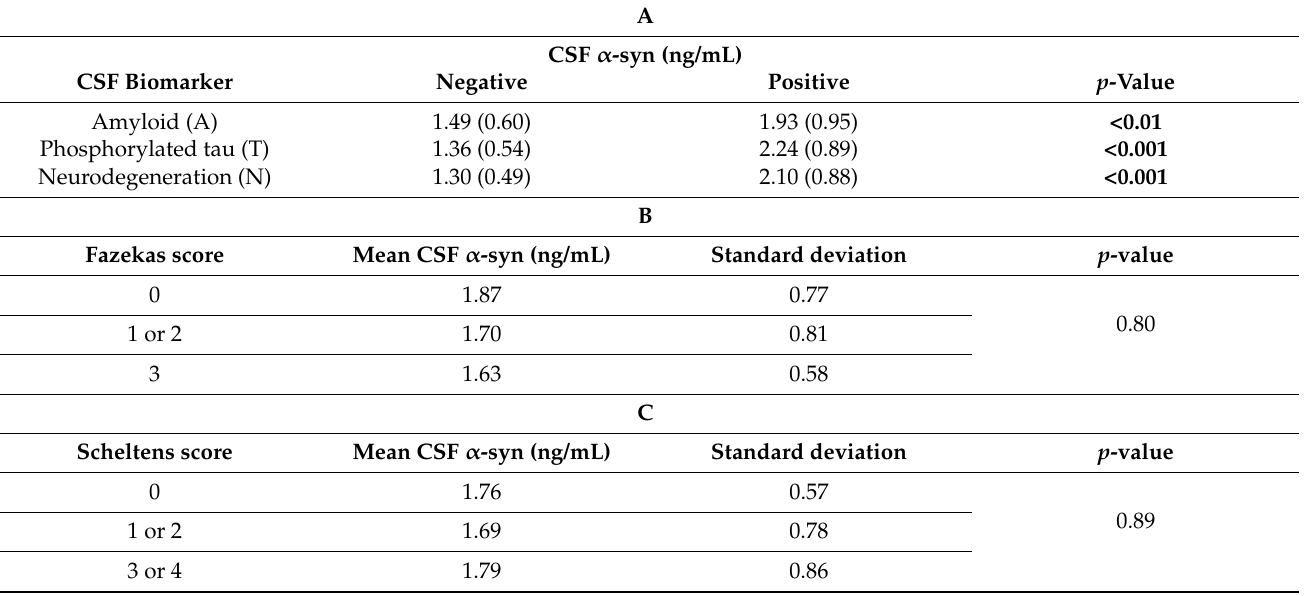
Table 2. A. Comparison of the mean CSF α -syn levels according to the positivity of AT(N) biomarkers. B. CSF α -syn levels regarding white matter lesions on brain MRI. C. α -syn concentrations regarding hippocampal